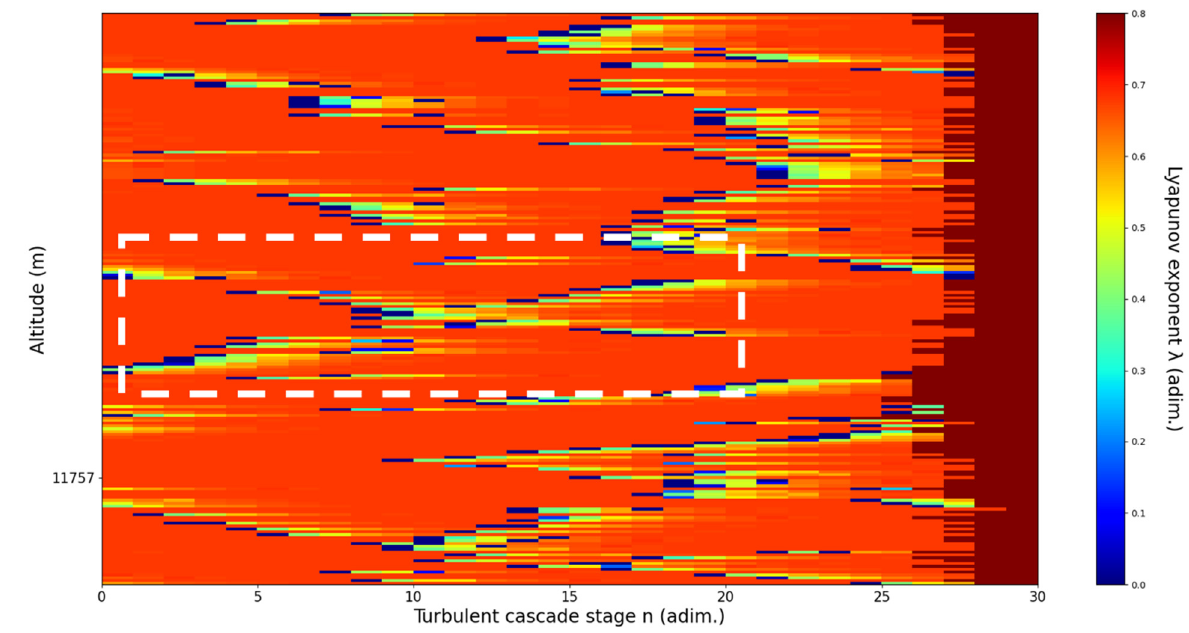
Figure 10. Lyapunov exponent per turbulent cascade stage colormap altitude plot, Bucharest, Romania, 13 June 2019,